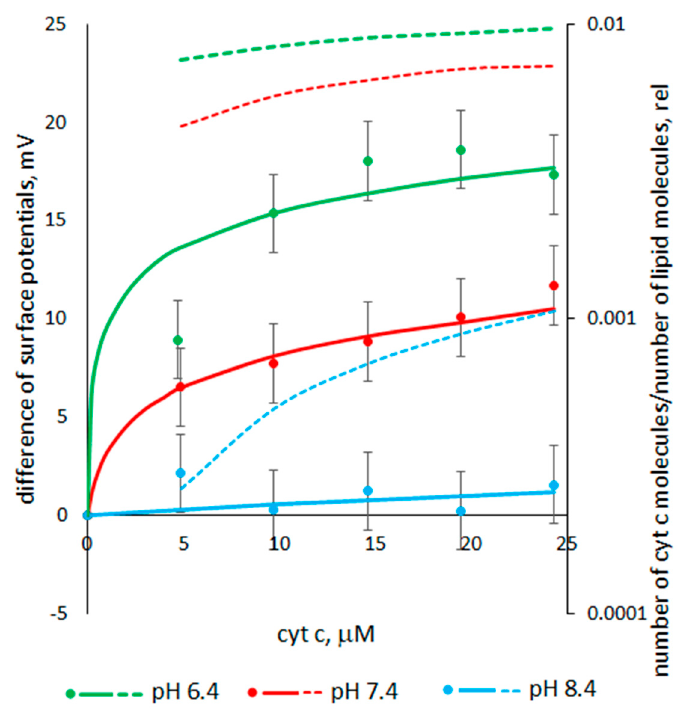
Figure 6. Experimental (markers) and calculated (curves) dependences of surface potential differ- ences, as well as calculated dependences (dotted line) of the ratio of the number of cyt c molecules adsorbed on the membrane to the number of lipid molecules in the membrane, on the cyt c concen- tration at different pHs: 6.4 (green), 7.4 (red), and 8.4 (blue). Calculated parameters: for pH 6.4, the binding constant K = 3000 C·m − 2 ·M − 1 , and the number of charges of the cyt c molecule z = +8.5; for pH 7.4, K = 110 C·m − 2 ·M − 1 , z = +7.25; and for pH 8.4, K = 1 C·m − 2 ·M − 1 , z = +6. The bulk solution is 0.1 M KCl.